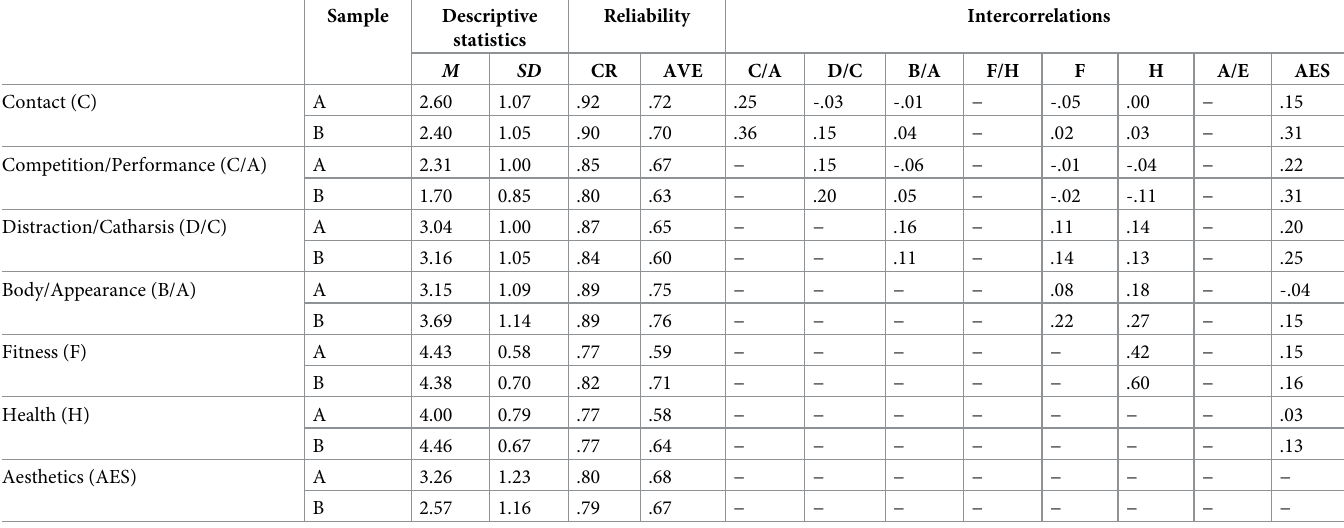
Table 6. Descriptive statistics, reliability and intercorrelations of the updated BMZI.